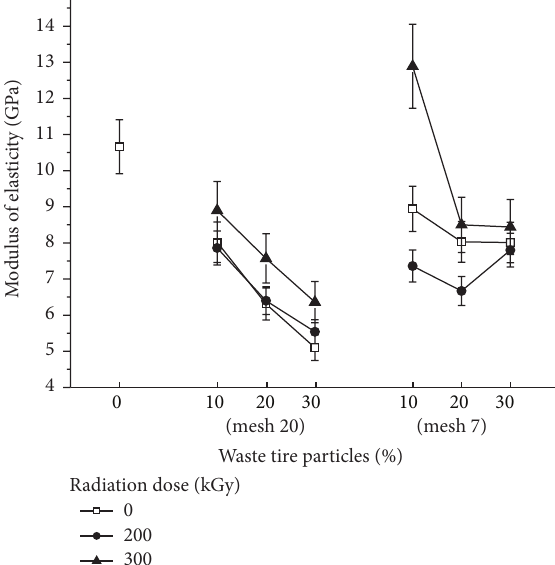
Figure 5: Flexural strength of concrete with waste tire particles of 0.85 mm and 2.8 mm.